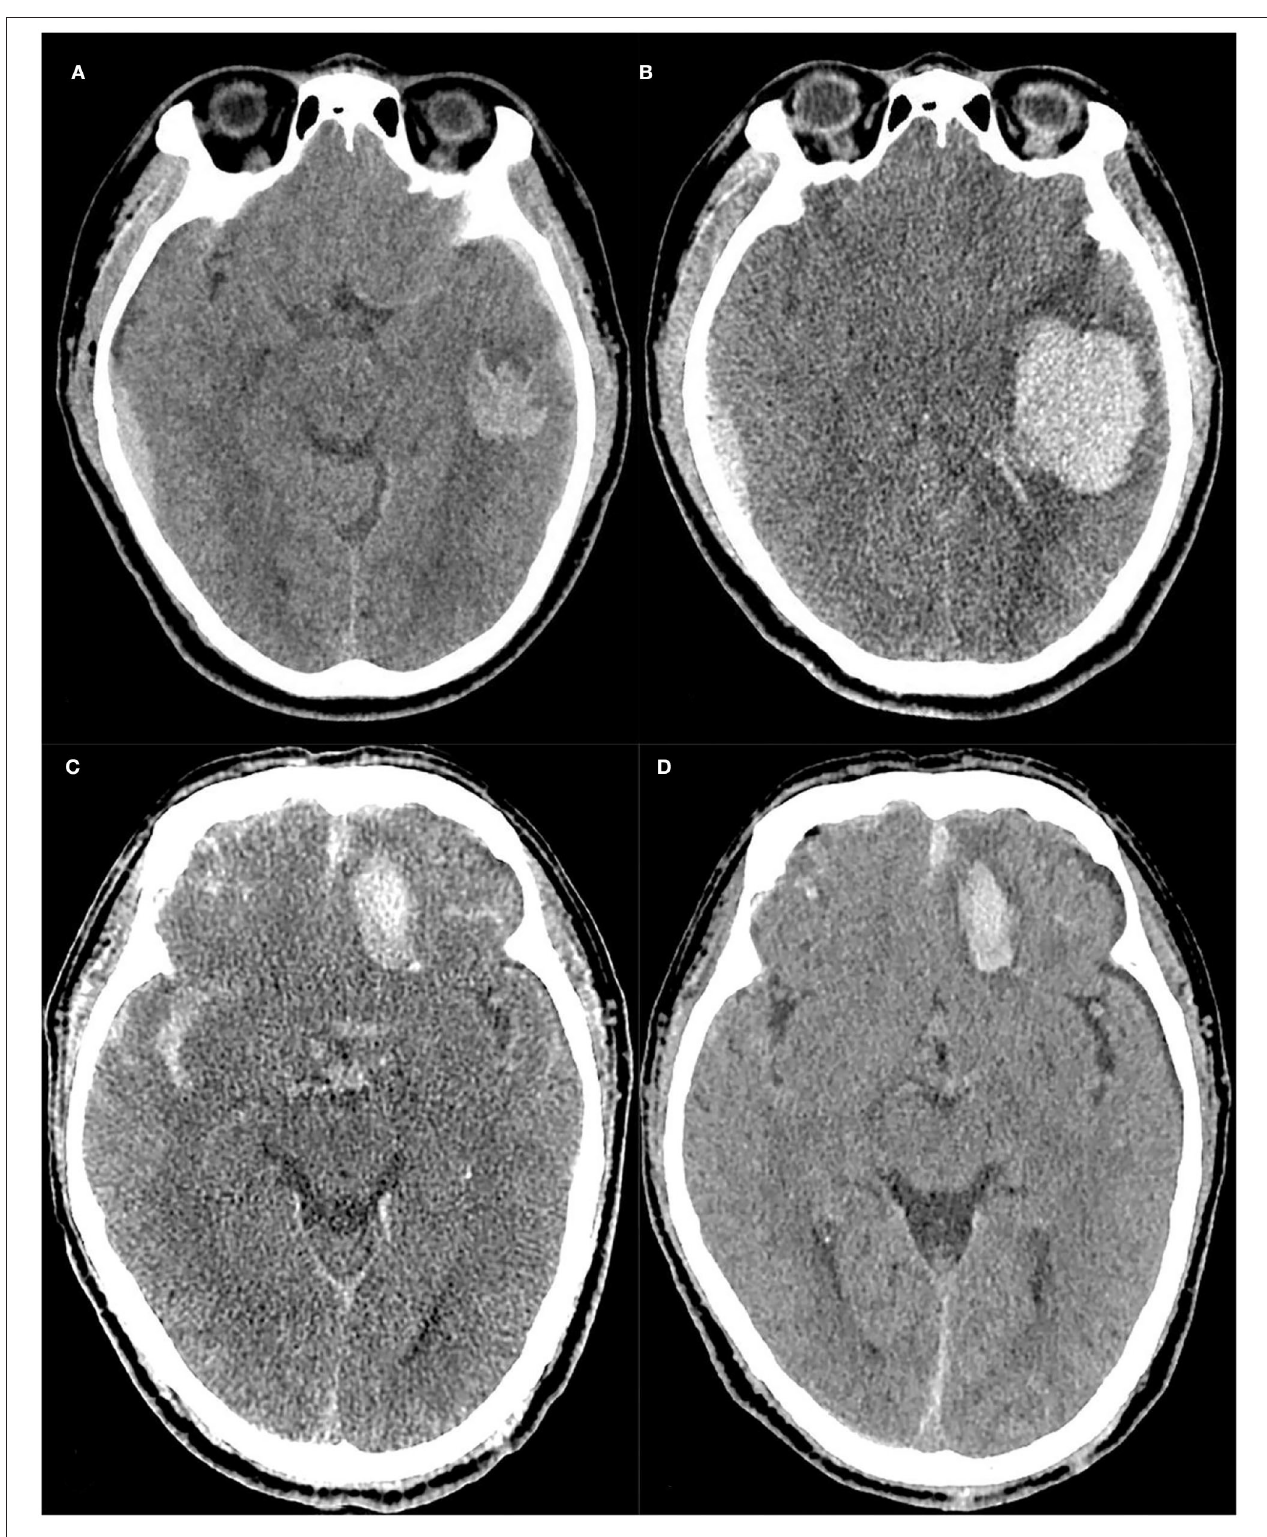
FIGURE 5 | Case 1: A case with progressive hemorrhage, The baseline and follow-up CT images of a TBI patient (A,B) , Scalp hematoma = 1, Fibrinogen = 2.68, Onset-to-CT time = 2h, R-score = 1.925. The risk of PH calculated by the nomogram was approximately 94%, and the hematoma volume was expanded to approximately 42.9ml on the follow-up 10-h CT compared to 10.5ml on the baseline CT. Case 2: A case without progressive hemorrhage, The baseline and follow-up CT images of another TBI patient (C,D) , Scalp hematoma = 1, Fibrinogen = 3.01, Onset-to-CT time = 6h, R-score = -1.144. The risk of PH calculated by the nomogram was approximately 0.044%. At 17h after trauma, the hematoma volume had not expanded.